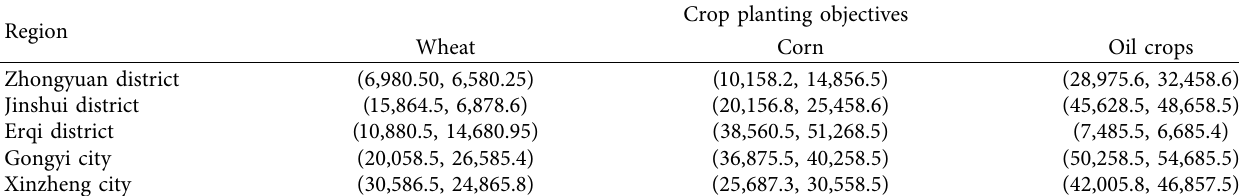
Table 1: Crop planting objectives of each district in Zhengzhou.